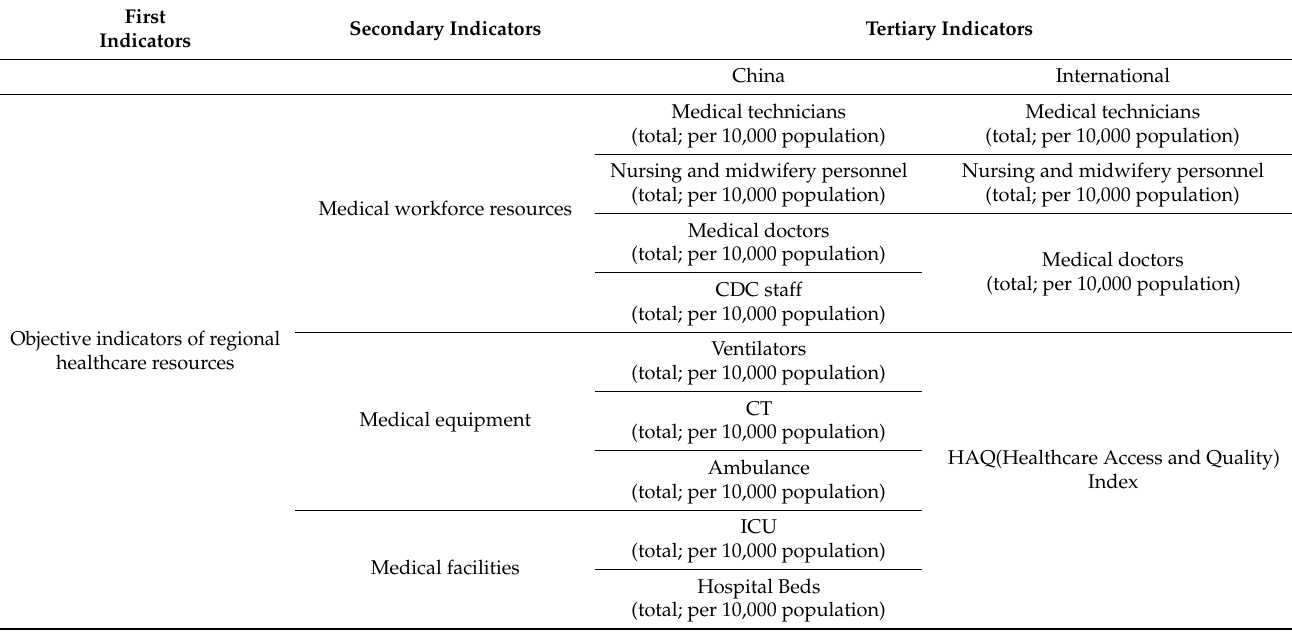
Table 1. The indicator system of the HRCC